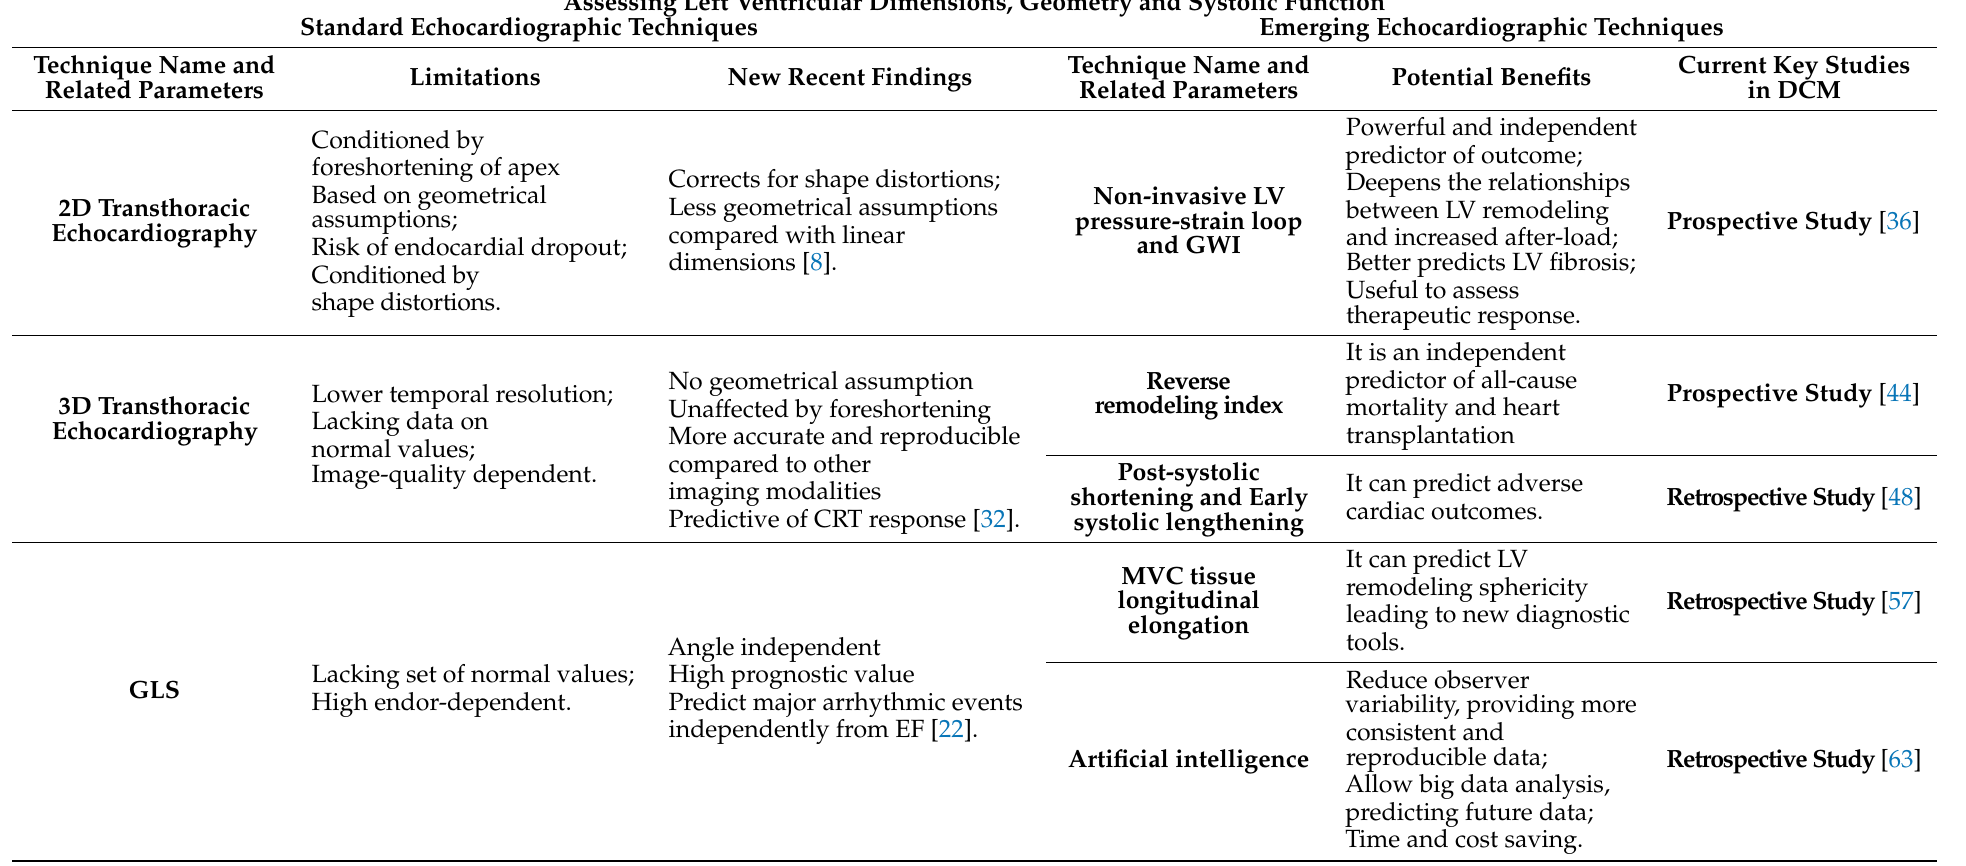
Table 1. Comparison between Standard and Emerging echocardiographic techniques to assess left ventricular dimensions, geometry and systolic function in dilated